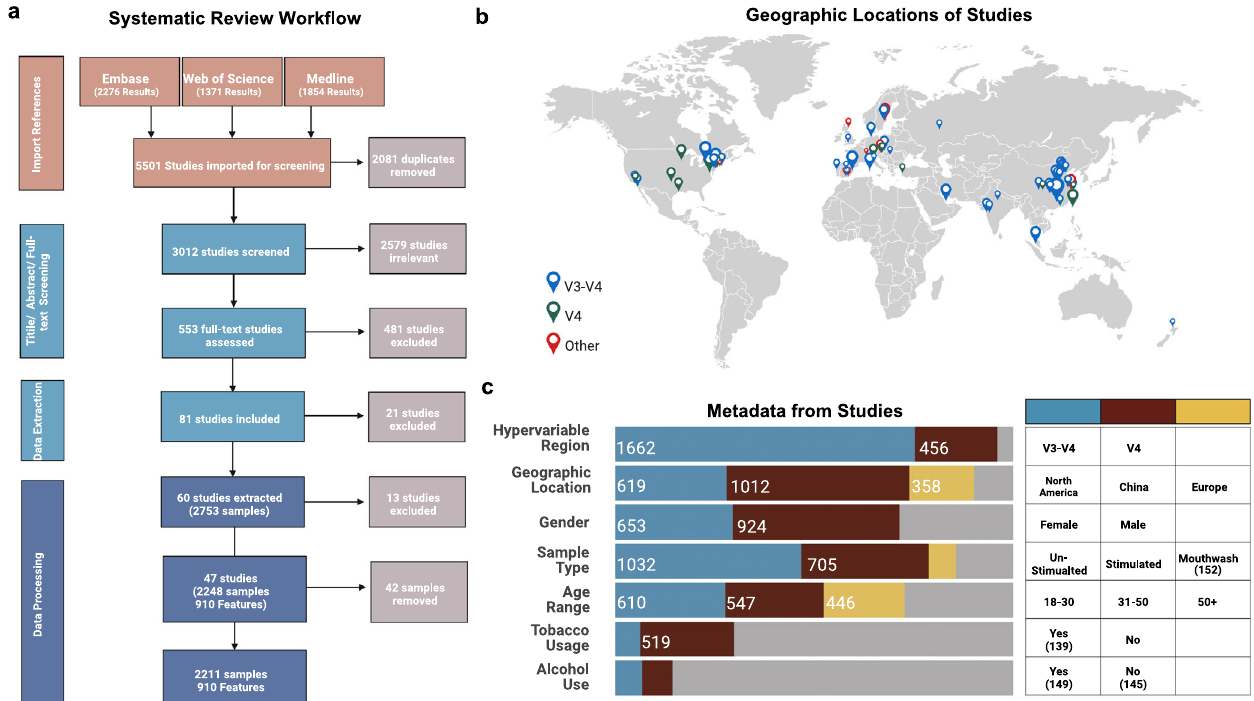
Fig. 1 Literature search procedure and metadata of included studies. a Large-scale literature searching and data fi ltering process, followed by the number of samples submitted to the bioinformatic analyses; b The locations of studies, the scale of symbols that re fl ect the number of samples of each study; c Distribution of metadata categories. Created with